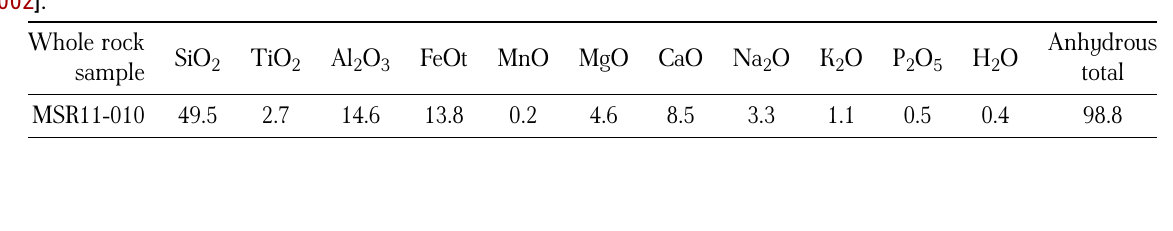
Table A1: Whole rock composition from Óskarsson [2015] used for the equilibrium test. Water content is based on Nichols et al. [2002].